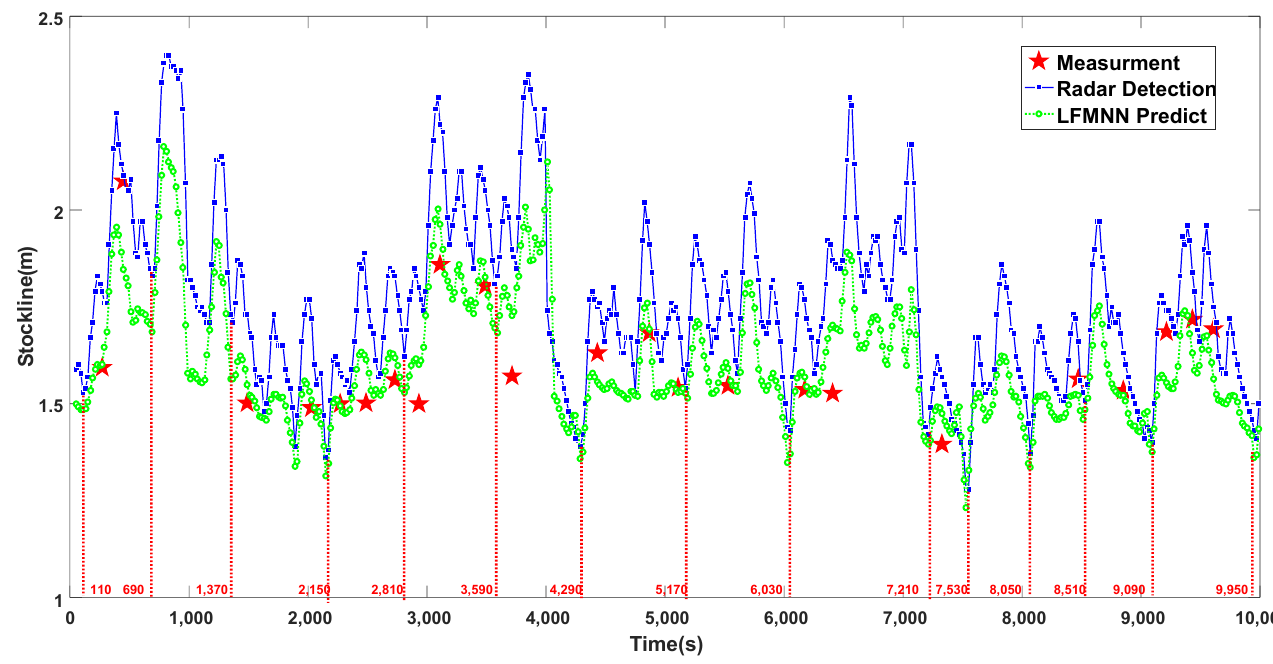
Figure 8. Trend of burden level prediction under abnormal working conditions. Table 1. Statistical prediction error comparison.